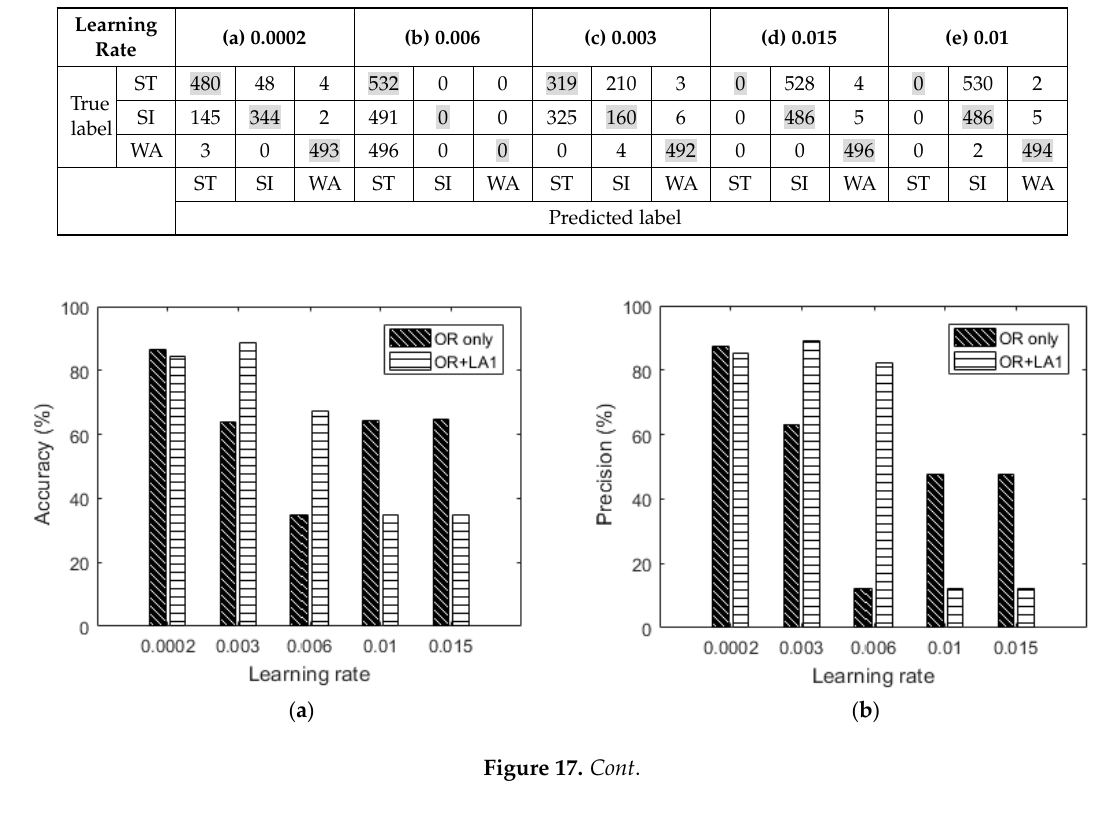
Table 12. Confusion matrices: (OR only).